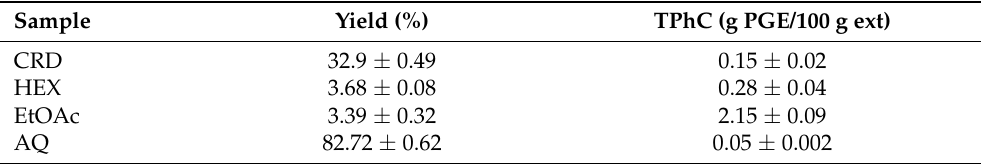
Table 1. Extraction yield (as % w / w of algal powder for crude extract and % w / w of crude extract for the fractions) and total phlorotannin content of H. elongata crude extract and further fractions. Sample Yield (%)